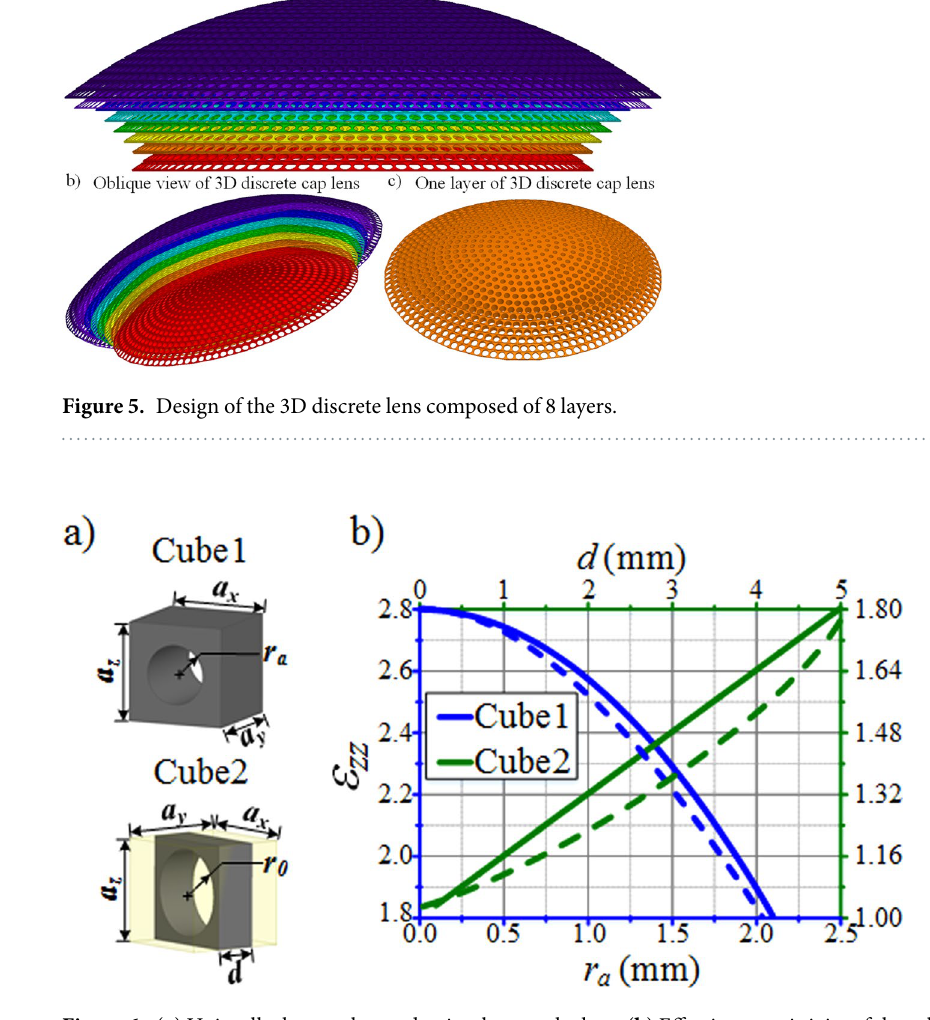
Figure 6. ( a ) Unit cells that can be used to implement the lens. ( b ) Effective permittivity of the cells composed of an air hole in a dielectric host medium. A parametric analysis is performed to extract the effective permittivity value according to the radius r a of the air hole for cube 1(with d equal to a y ) and to the thickness d for cube 2. The continuous traces correspond to approximate values calculated using the mixing formula and the dashed traces correspond to accurate values retrieved from homogenization